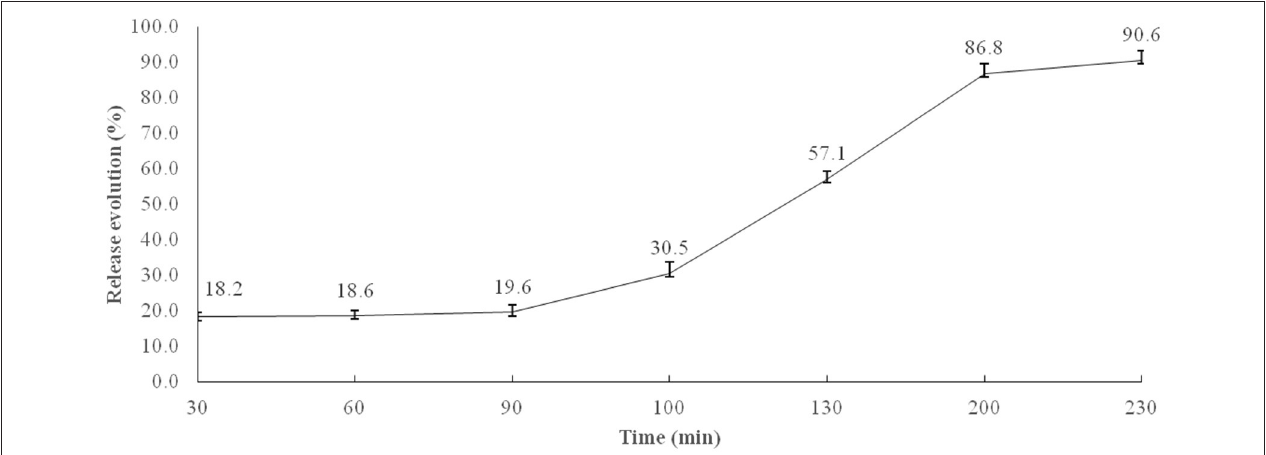
FIGURE 1 | In vitro microencapsulated BB release profile in simulated stomach (0–90min) and small intestine conditions (90–230min). Each value is the average release of four flasks at simulated conditions of the crop, 0–30min; gizzard, 30–90min; duodenum, 90–100; jejunum, 100–130min; ileum, 130–200min; and cecum,